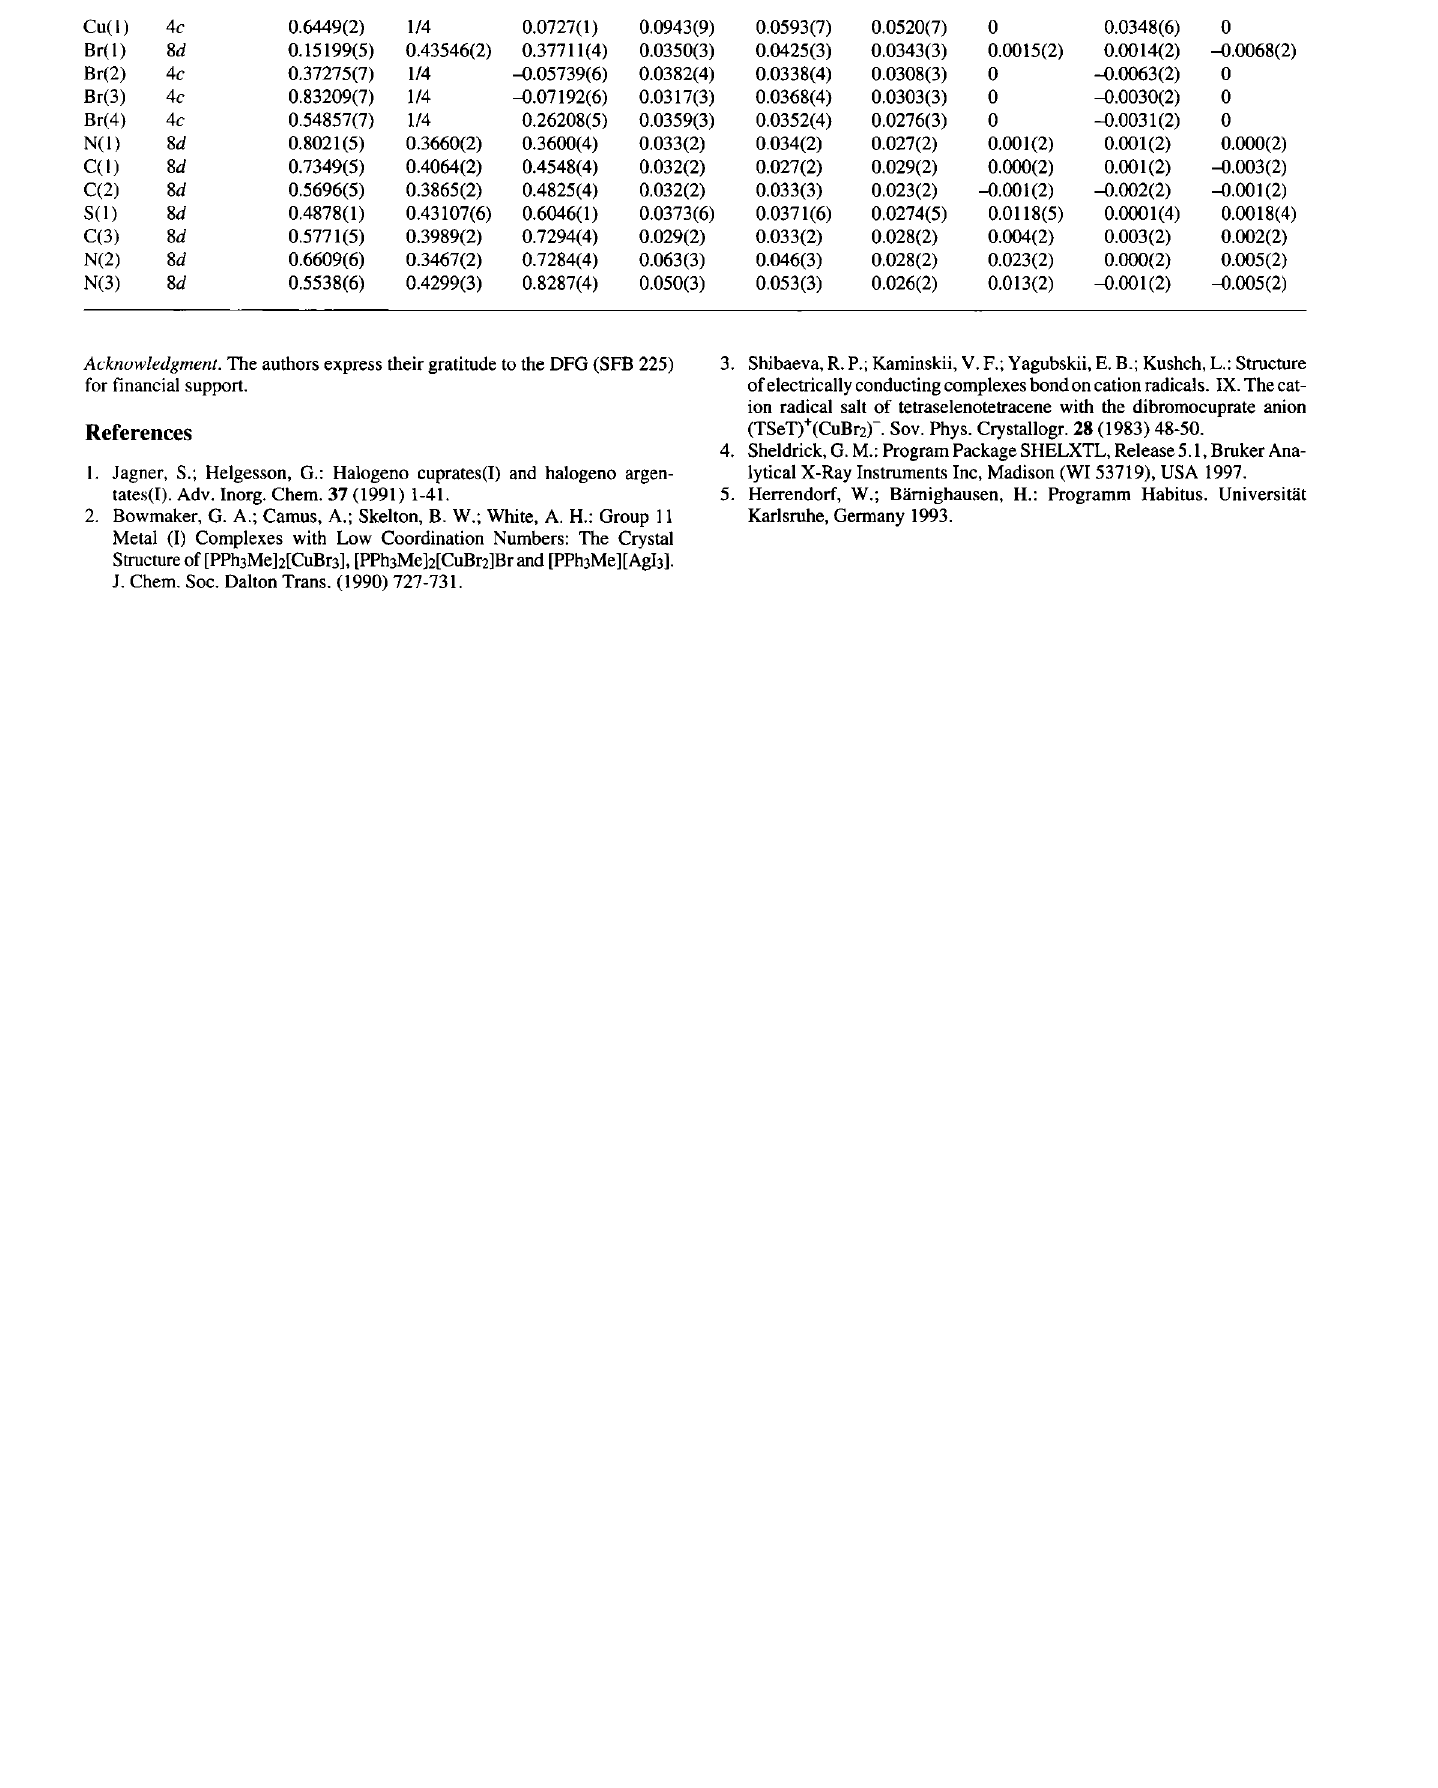
Table 3. Atomic coordinates and displacement parameters (in A 2